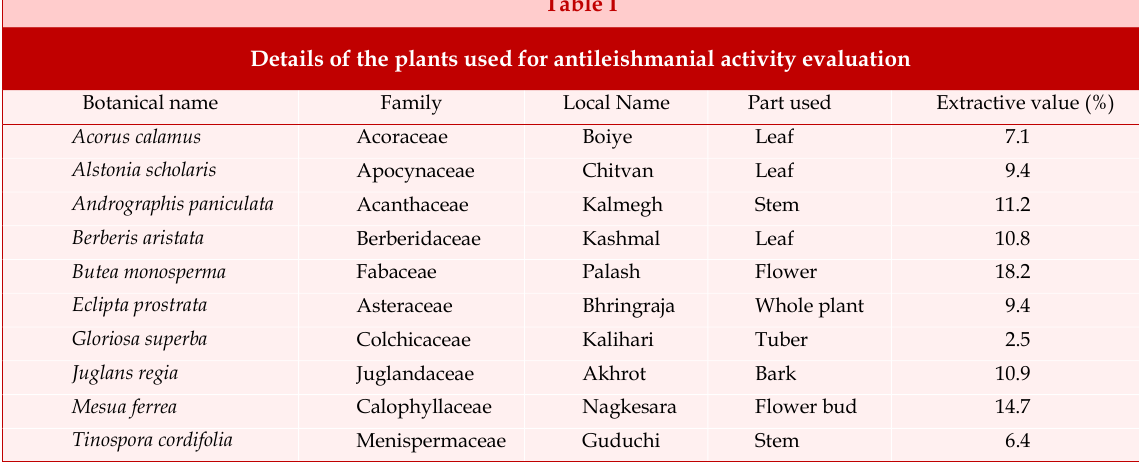
Details of the plants used for antileishmanial activity